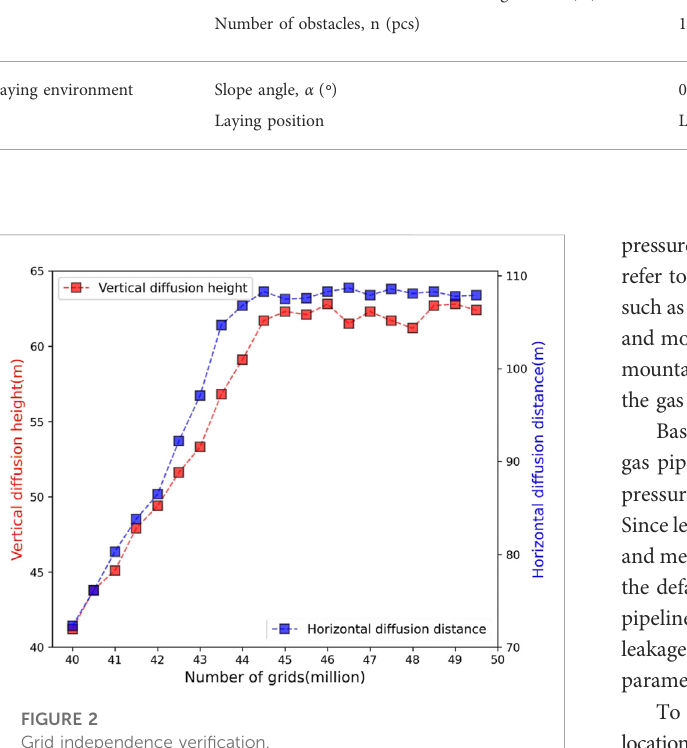
FIGURE 2 Grid independence veri fi